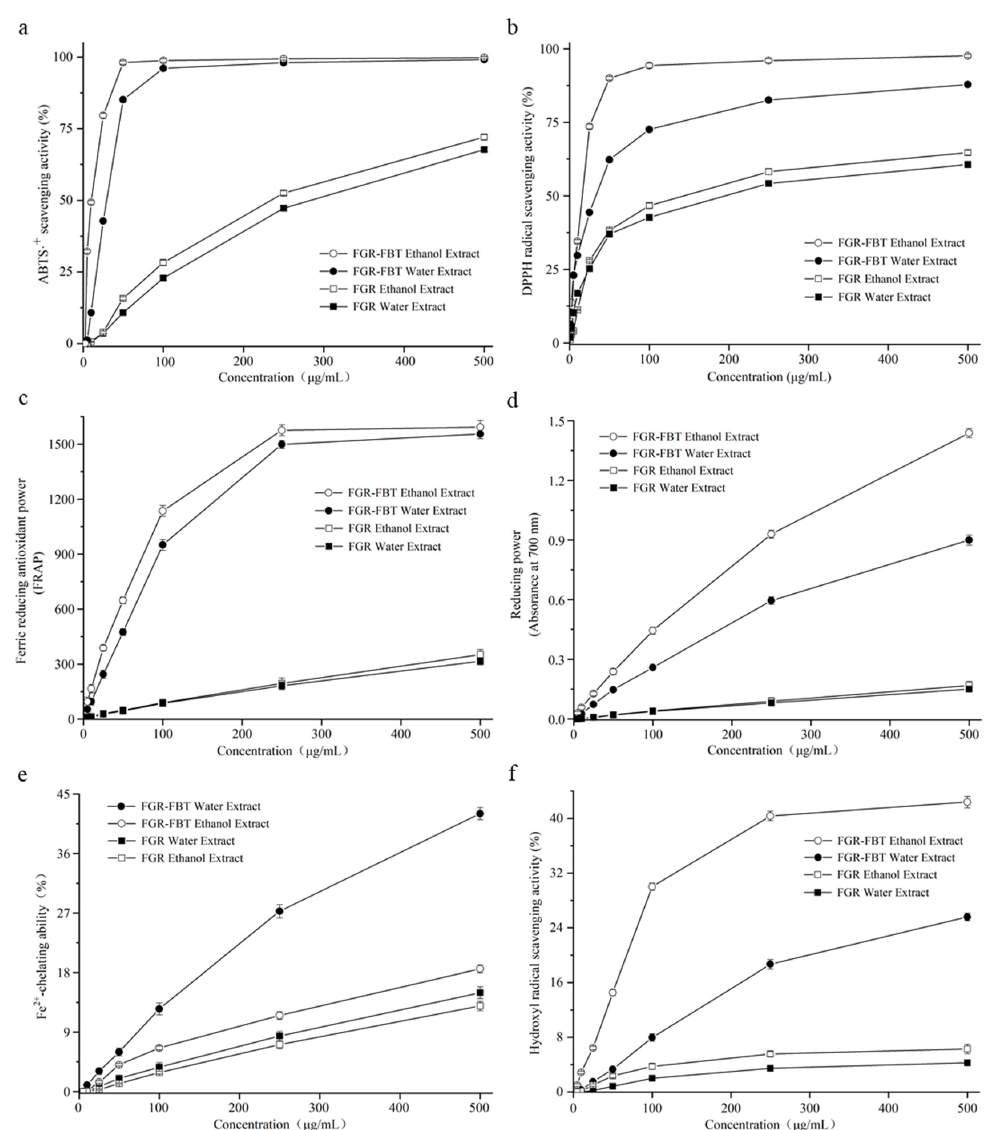
Figure 3. Antioxidant properties of hydroalcoholic extracts (80% ethanol extracts) and water extracts of fermented glutinous rice with Fu brick tea (FGR-FBT) and traditional fermented glutinous rice (FGR) evaluated by different methods: ABTS· + (2,2 ′ -azino-bis-3-ethylbenzthiazoline-6-sulphonic acid) radical-scavenging activity ( a ), DPPH (1,1-Diphenyl-2-picryl-hydrazyl) radical-scavenging activity ( b ), ferric-reducing antioxidant power (FRAP) ( c ), reducing power ( d ), Fe 2+ -chelating ability ( e ) and hydroxyl radical-scavenging activity ( f ). Table 3. IC 50 values in antioxidant properties of water and hydroalcoholic extracts (80% ethanol extracts) of fermented glutinous rice with Fu brick tea (FGR-FBT) and traditional fermented glutinous rice (FGR).